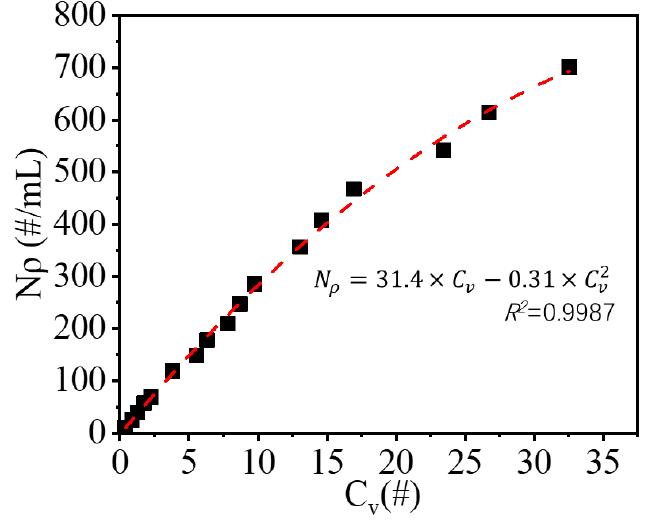
Figure 2. Calibration line of the particle suspension number density in solution.